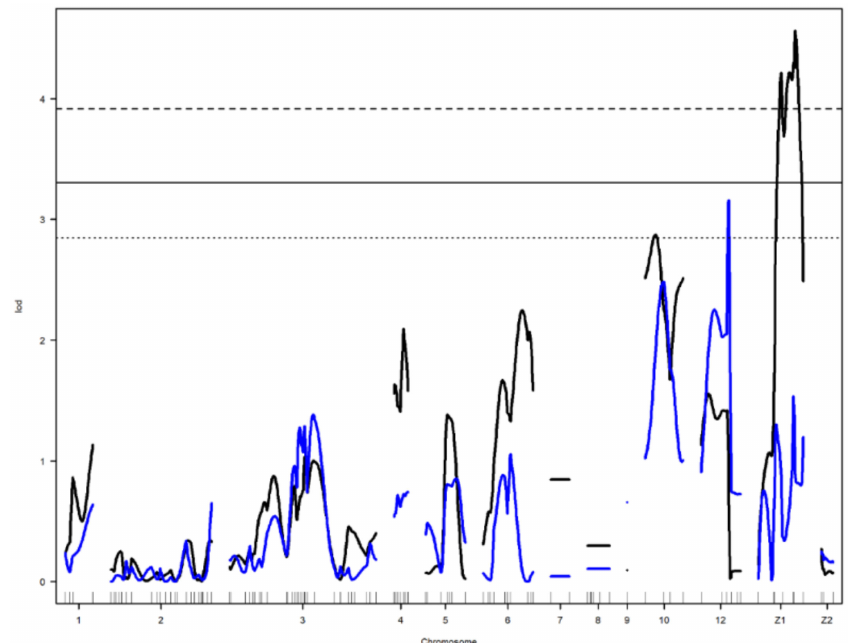
Figure 5. Genome-wide LOD plot of detected QTL for egg shell weight 1 (blue) on chromosome 12 and yolk diameter 1 (black) on chromosome Z1. The horizontal lines show the genome-wide significance threshold at 1% (dashed line) and 5% (straight line) and suggestive threshold at 10% (dotted line)